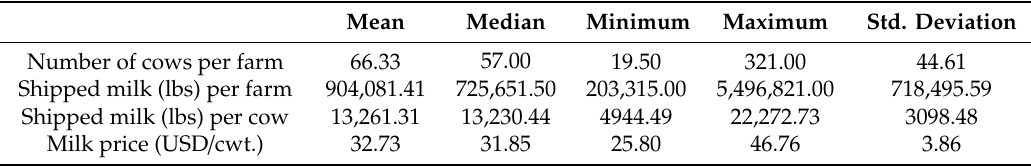
Table 1. UVM / NOFA Organic Dairy Study Production Variables: 2006–2016 Average (n = 392). Mean Median Minimum Maximum Std. Deviation Number of cows per farm 66.33 57.00 19.50 321.00 44.61 Shipped milk (lbs) per farm